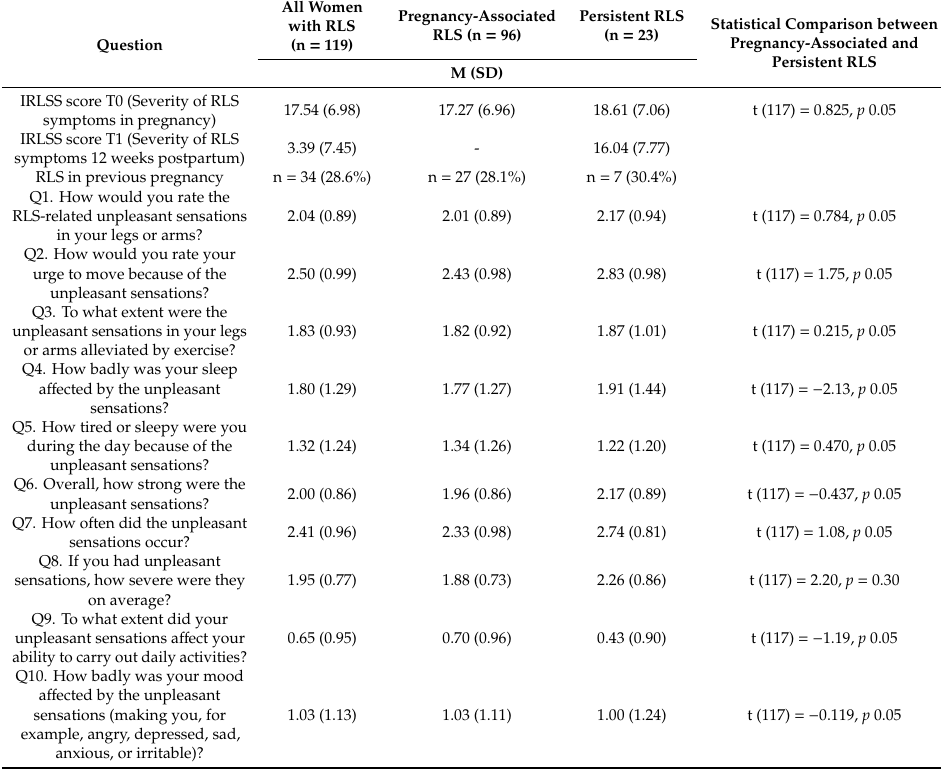
Table A5. The IRLSS